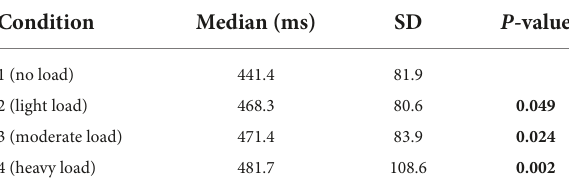
TABLE 1 Median hit reaction times across inspiratory threshold loading